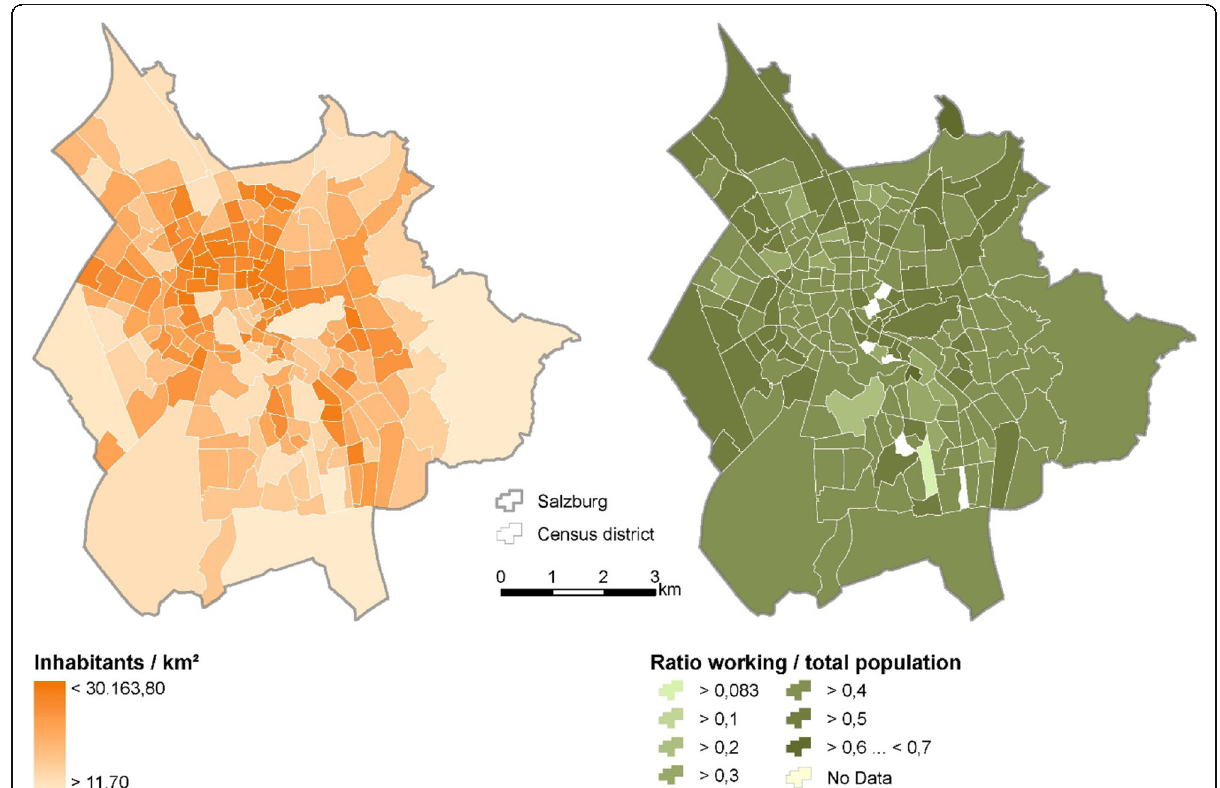
Fig. 4 Examples for dimensions that describe the city ’ s spatial